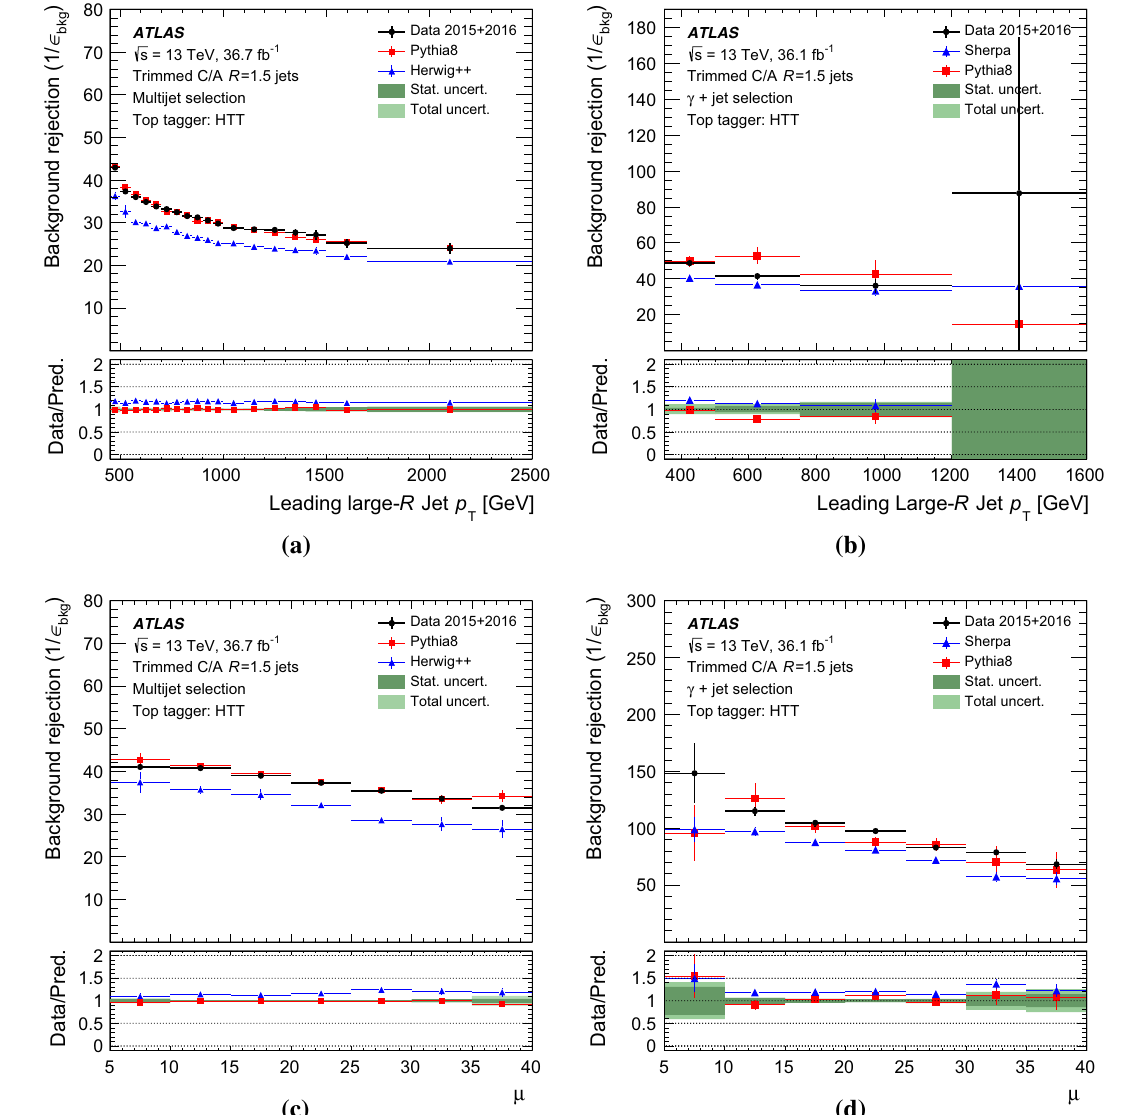
Fig. 39 The estimated light-jet rejection 1 /(cid:12) bkg as a function of the leading jet p T and the average number of interactions per bunch crossing μ for the HEPTopTagger in the multijet ( a , c ) and γ + jet ( b , d ) selection